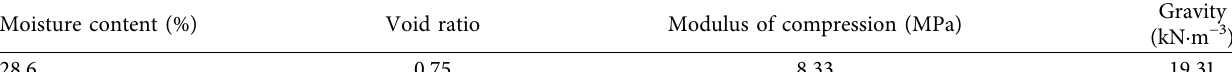
Table 1: Basic physical properties of silty clay.